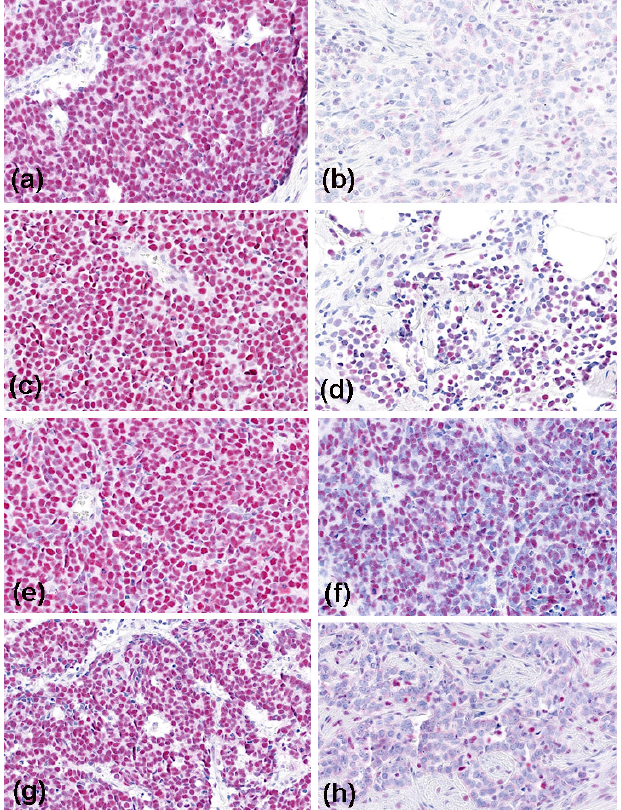
Figure 1. Immunoreactivity of the mismatch repair proteins in Merkel cell carcinoma (magnifica- tion, ×200). High expression (all MCPyV-positive cases) is shown on the left side: MLH1 ( a ), MSH2 ( c ), MSH6 ( e ), and PMS2 ( g ); and low-level expression (all MCPyV-negative cases) on the right side: MLH1 ( b ), MSH2 ( d ), MSH6 ( f ), and PMS2 ( h ).